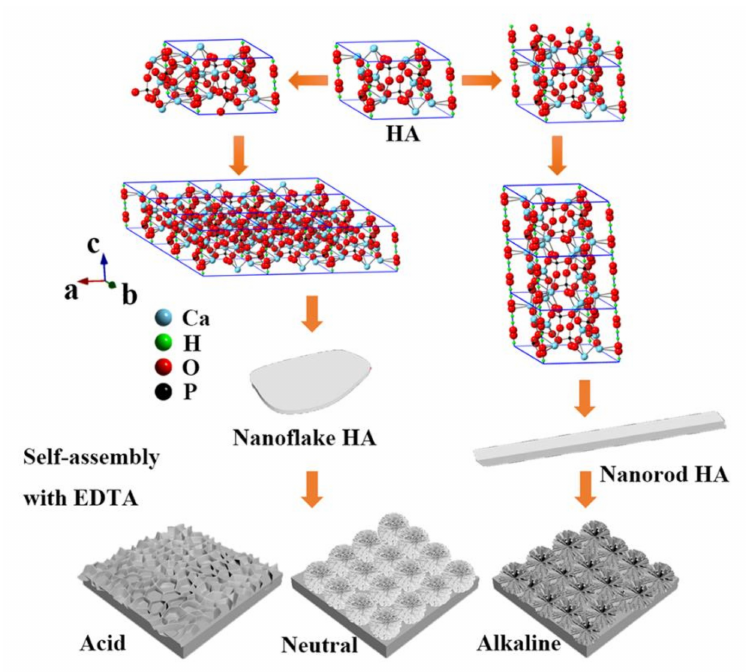
Figure 11. Diagram of the formation mechanism of different HA